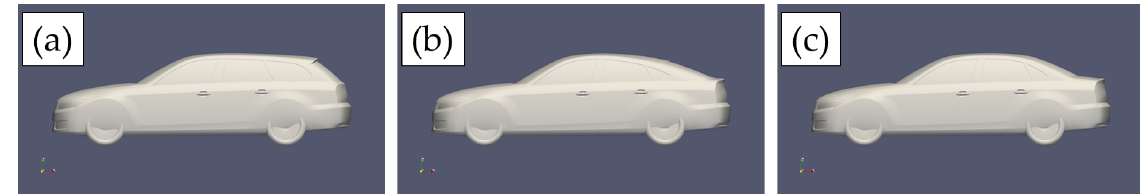
Figure 3. Appearance of the DrivAer Models, as shown in ( a ) Estateback, ( b ) Fastback, and ( c ) Notchback. Only the rear shapes of the vehicles are different from each